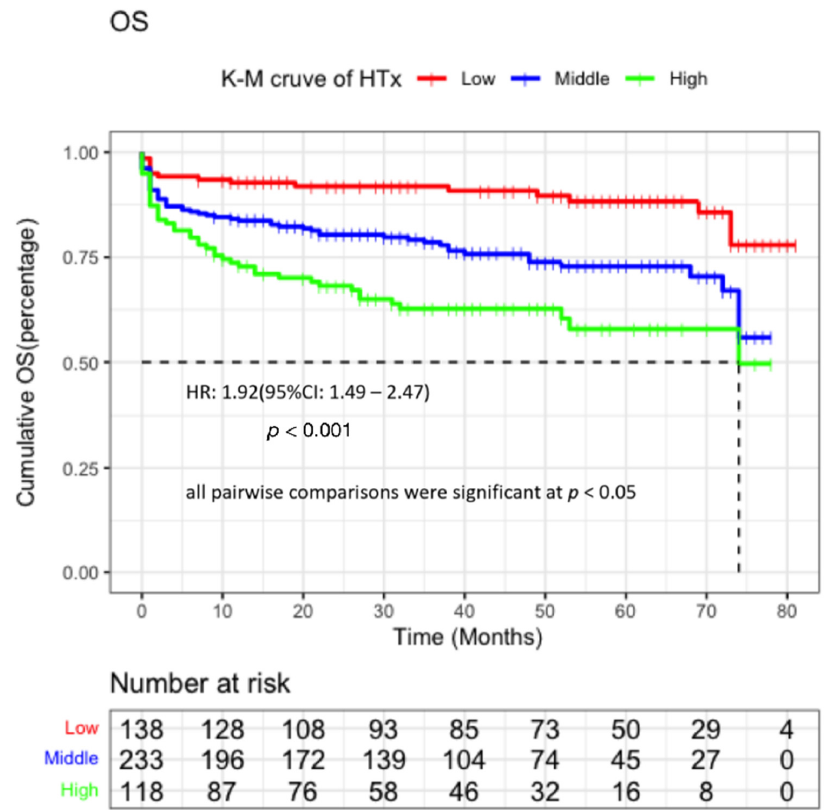
Figure 5. KM curve for combined indicators. Table 4. Diagnostic evaluation of PNI and BNP in OS of Patients with heart transplantation.